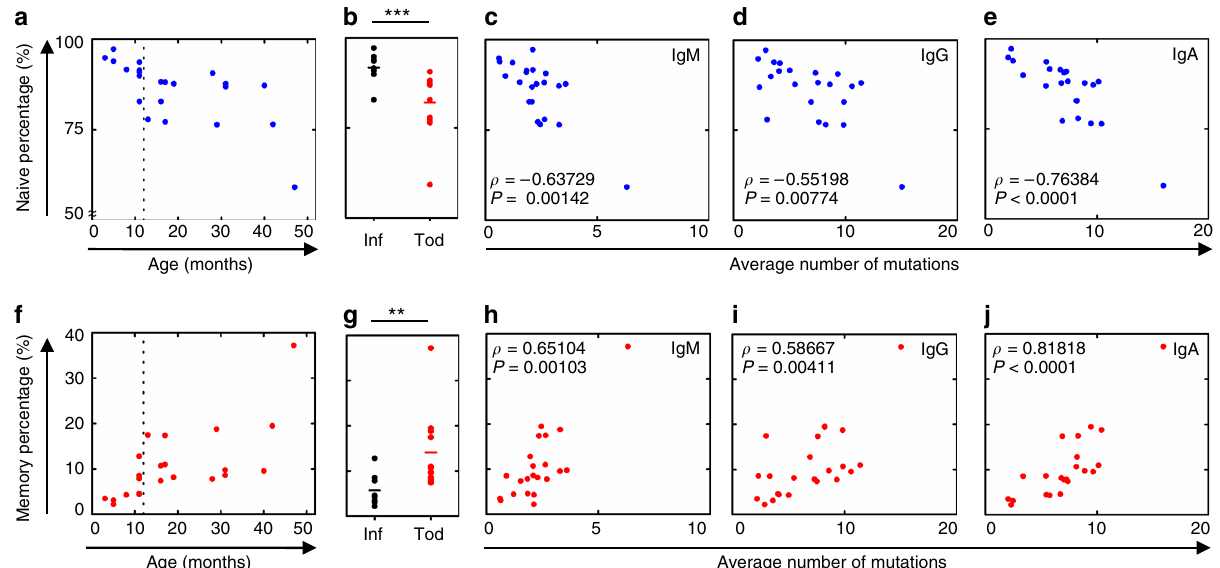
Fig. 3 Decrease of naive B cell and increase of memory B cell percentages show a two-stage trend and correlate with SHM load. a Naive B cell percentages of total B cells from the pre-malaria samples ( N = 22) vary with age. Dashed vertical line depicts the cutoff between infants and toddlers. b Naive B cell percentages of total B cells compared between infants ( black , N = 9) and toddlers ( red , N = 13). c – e Naive B cell percentages correlate with average number of mutations (SHM load) in IgM ( c ), IgG ( d ), and IgA ( e ) sequences from bulk PBMCs in pre-malaria samples ( N = 22). f Memory B cell percentages of total B cells from the pre-malaria samples ( N = 22) vary with age. Dashed vertical line depicts the cutoff between infants and toddlers. g Memory B cell percentages of total B cells compared between infants ( black , N = 9) and toddlers ( red , N = 13). h – j Memory B cell percentages correlate with average number of mutations (SHM load) in IgM ( h ), IgG ( i ), and IgA ( j ) sequences from bulk PBMCs in pre-malaria samples ( N = 22). b , g Bars indicate means; ** P < 0.01, *** P < 0.001, two-tailed Mann – Whitney U test. c – e , h – j ρ and P values determined by Spearman ’ s rank correlation listed in each